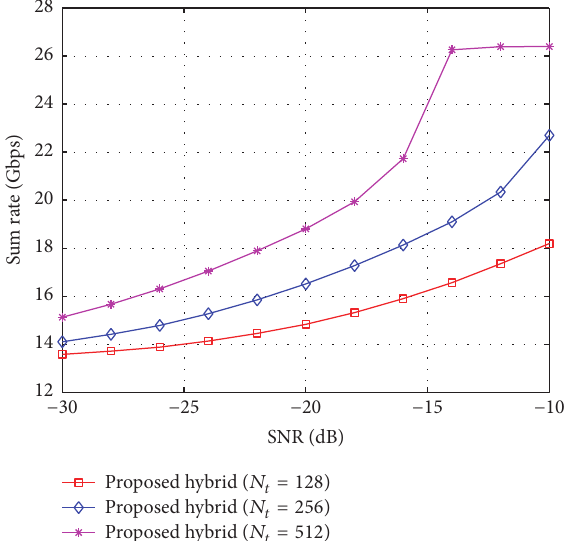
Figure 4: Sum rates versus SNR using the proposed hybrid beam- forming algorithms when 𝐾 = 4 and 𝑁 𝑡 = 128,256,512